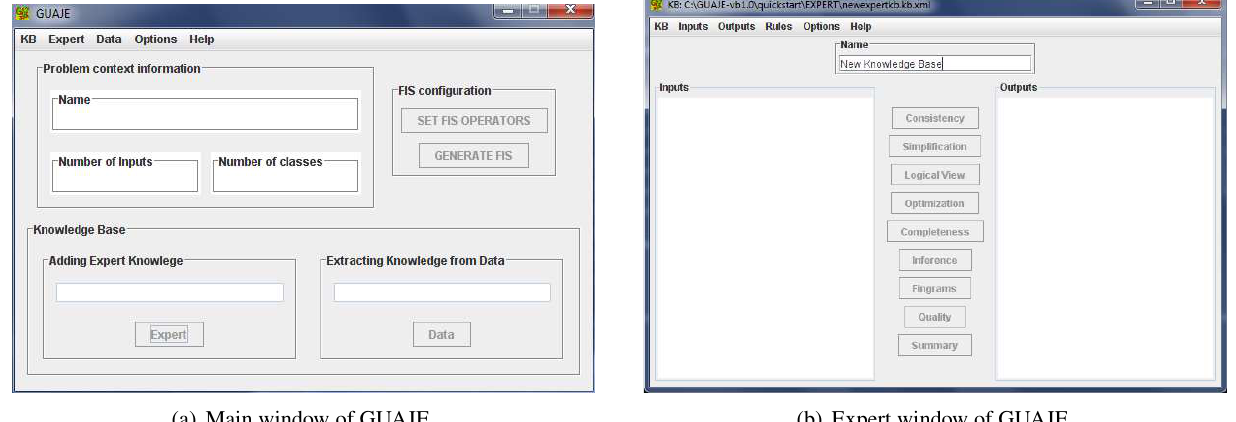
Figure 2: Screenshots of